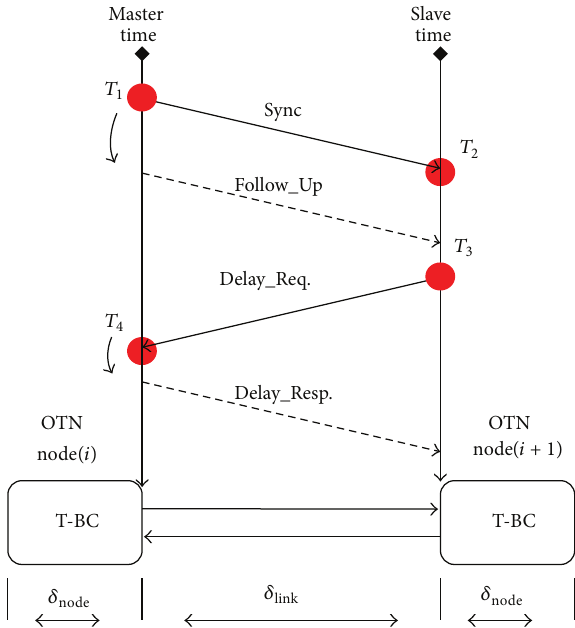
Figure 5: Time transfer mode based on T-BC